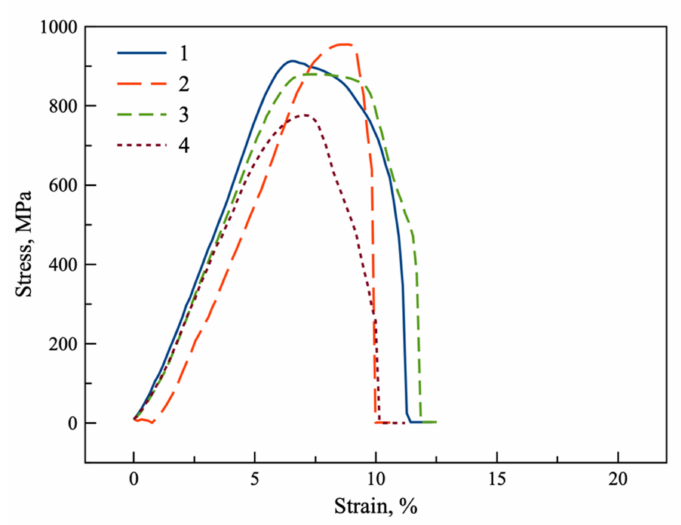
Figure 9. Stir zone material tensile test